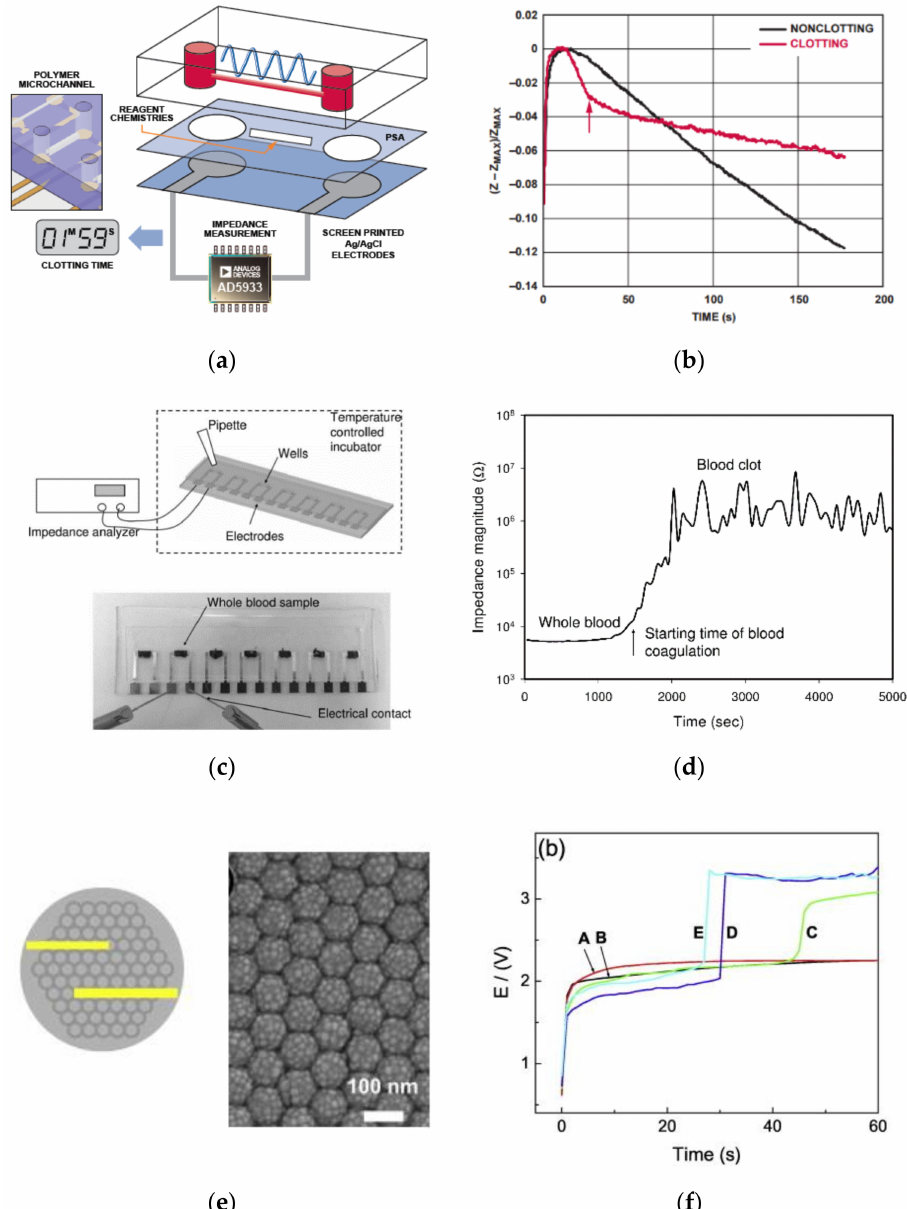
Figure 11. ( a ) Schematic of the impedance measurement system embedded with screen printed electrodes across the polymer microchannel designed to interface between the sample and the AD5933 instrumentation. ( b ) Impedance profiles for a nonclotting (black) and clotting (red) blood sample using AD5933 instrumentation (Reprinted with permission ref. [73]. Copyright 2008 Analog Devices, Inc.). ( c ) Illustration and the photograph of the real-time electrical impedimetric microfluidic chip developed by Lei et al. ( d ) Impedimetric profile for blood coagulation process at 1000 Hz. (Reprinted with permission from ref. [72]. Copyright 2013 Lei et al.) ( e ) Nanodots array along with the gold electrodes formed by sputtering, depicted using yellow lines and FE-SEM images of the same(surface). ( f ) Coagulation profiles in Au@nano-epoxy with A and B being blood sample and blood coagulation reagent, respectively, whereas C–E are the results of blood coagulation on Au@nano-epoxy along with coagulating reagents of 1, 3, and 5 µ L, respectively. (Reprinted with permission from ref. [81]. Copyright 2009 Elsevier